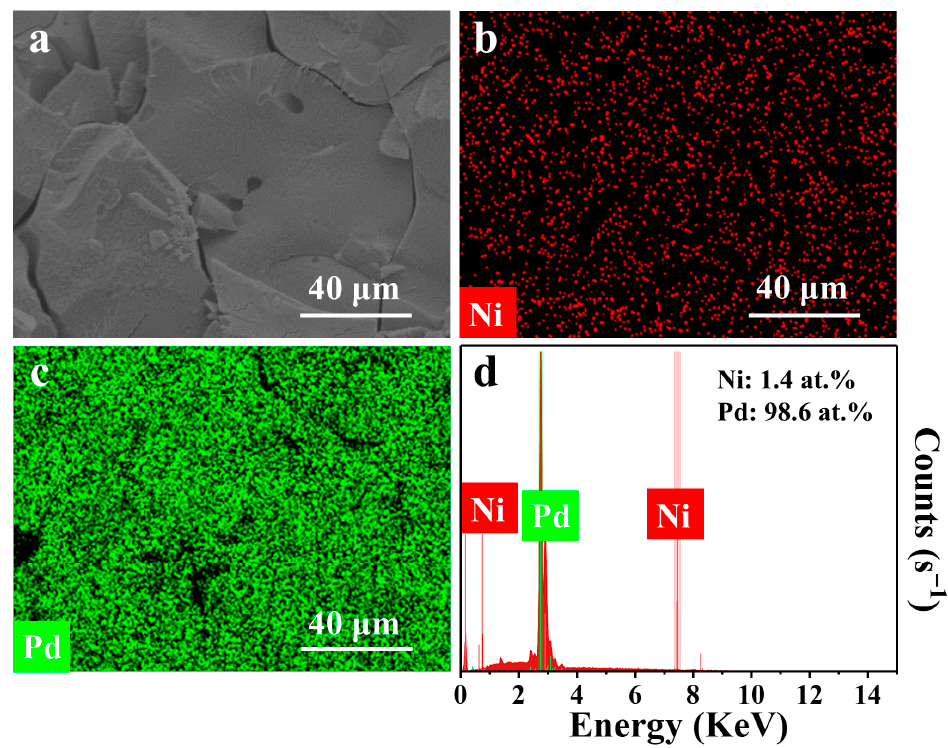
Figure 8. ( a ) Low-magnification SEM image and ( b , c ) the elemental distribution mappings of the bulk np-Pd fabricated by the two-step potentiostatic dealloying of Ni 80 Pd 20 . ( d ) The EDS spectrum of the bulk np-Pd, and the average residual amount of Ni is 1.4 at.%. Consistent with the EDS results (Figure 8), the XRD pattern (Figure 9a) of the np-Pd reveals that only one set of diffraction peaks attributed to the fcc Pd phase (PDF # 46-1043) can be indexed. After the two-step potentiostatic dealloying, the cross-sectional SEM im- ages of the bulk np-Pd (Figure 9b,c) present a uniform rather than hierarchical nanopo- rous structure with a ligament size of ~22 nm (inset in Figure 9c). The densely continuous nano-sized ligaments will provide good network connectivity for inducing strains [12,22]. The TEM images (Figure 9d,e) further reveal the dense nanoporous structure of the np- Pd. The black ligaments and bright nanopores are intertwined to form the interconnected ligament-channel network. In addition, the plane spacing (2.284 Å) in the high-resolution TEM (HRTEM) image (Figure 9f) is in accordance with the (111) crystal plane (2.246 Å) of the fcc Pd phase, and the selected-area electron diffraction (SAED) pattern (inset of Figure 9f) shows a series of visible polycrystalline rings, which can be indexed as (111), (200), (220) and (311) reflections of fcc Pd. These results demonstrate that the bulk np-Pd with a uniform and dense nanoporous structure was successfully fabricated by the two-step po- tentiostatic dealloying.